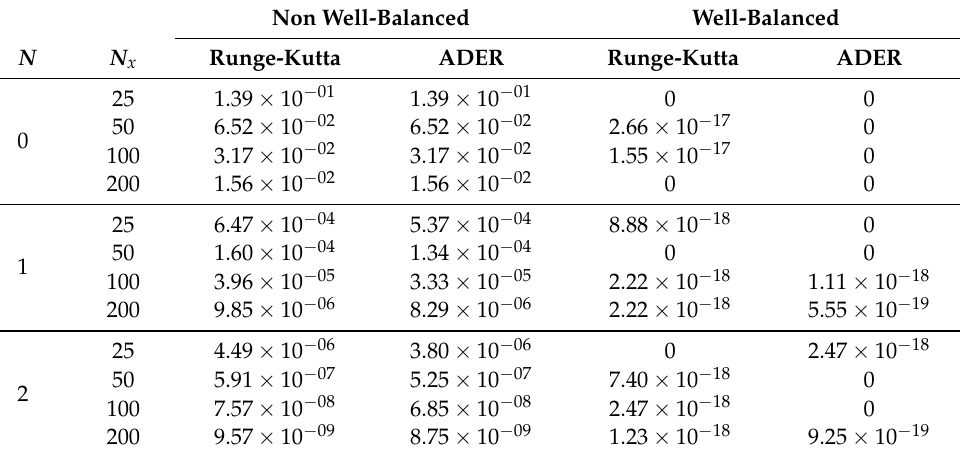
Figure 1. Fluctuation ( u − e H ) for the stationary problem (44) for the Burgers’ equation at time t = 10 s with the fourth order non well-balanced ( left ) and well-balanced ( right ) numerical schemes. An uniform Cartesian mesh of N x = 50 elements has been used. Upper and lower panels stands for Runge–Kutta and ADER time-marching discretisations, respectively. Table 1. Numerical validation of the well-balanced and non well-balanced methods for the stationary problem (44) (Burgers’ equation). Table contains L 1 errors for the variable u at a final time t = 10 s for both Runge–Kutta and ADER DG schemes of order N + 1 = 1, 2, 3, 4. Uniform Cartesian meshes of N x elements has been